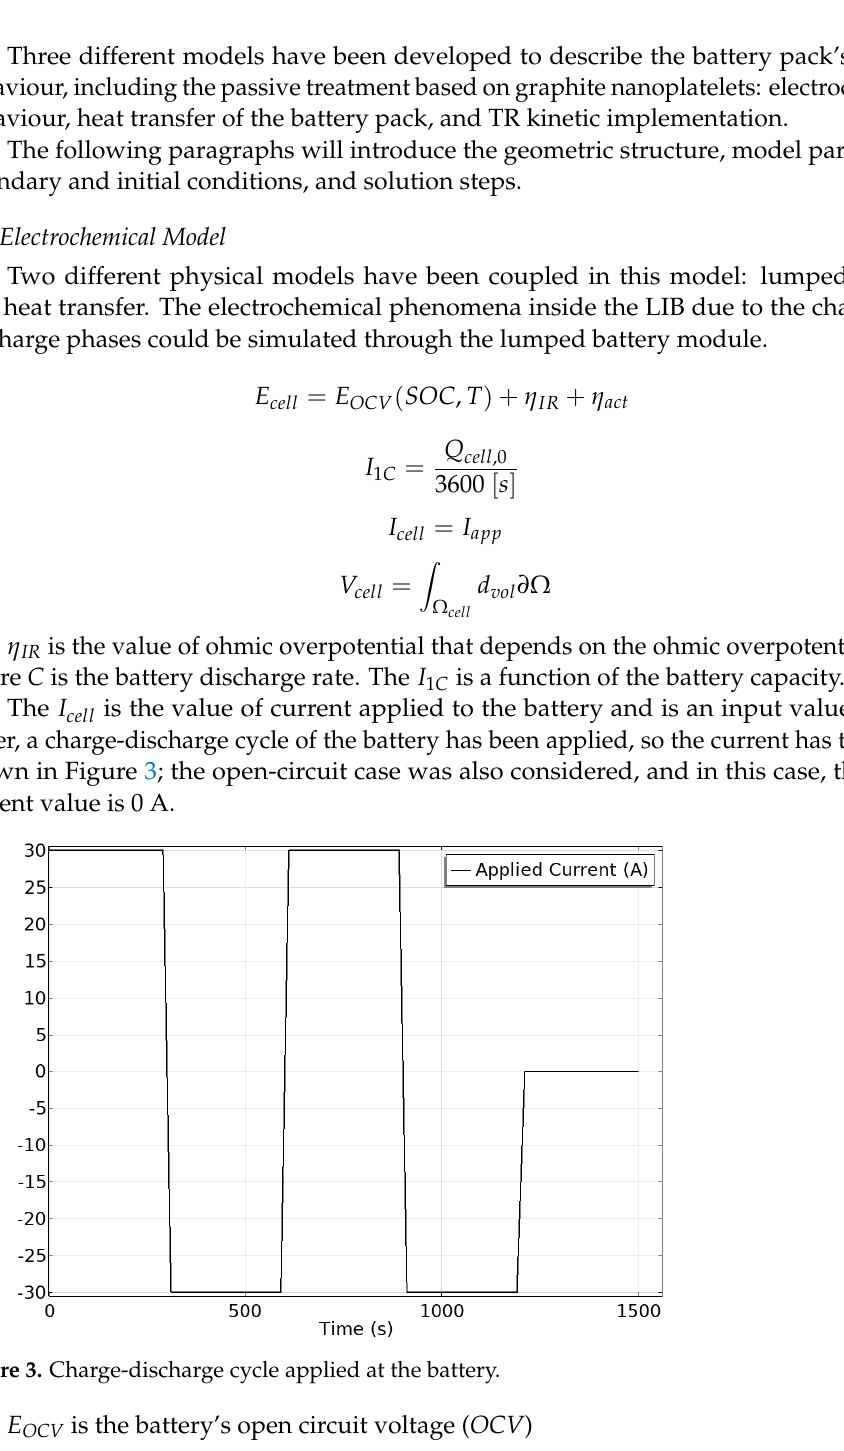
E OCV , ref is the open circuit voltage at the reference temperature depending on the battery’s state of charge ( SOC ); it is an intrinsic property of the battery [8], and its trend is reported in Figure